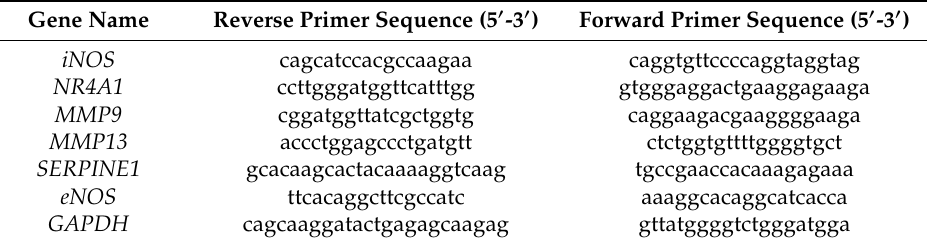
Table 1. Primers used for the real-time